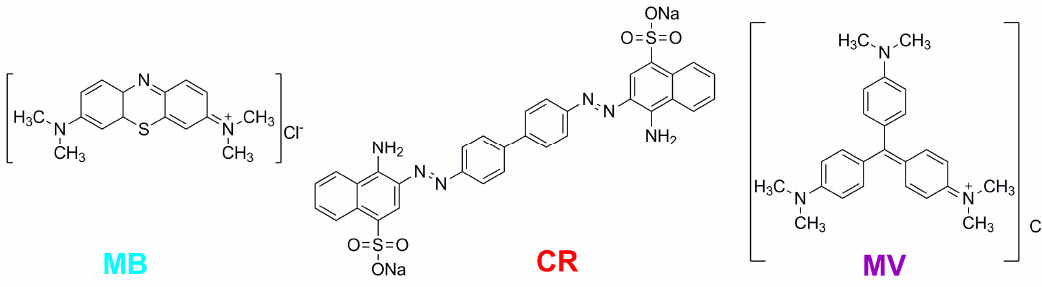
( b ) Figure 6. ( a ) Relationship between adsorbed quantities ( q t ) of the dyes and time. ( b ) Effect of contact time on the removal of the organic dyes by Cu 3 (BTC) 2. H 2 O. The maximum dye uptake on MOF occurred in the pH range 5–7 with a removal percent of ~ 90% (Figure 7), illustrating the excellent pH window offered by this adsorbent.